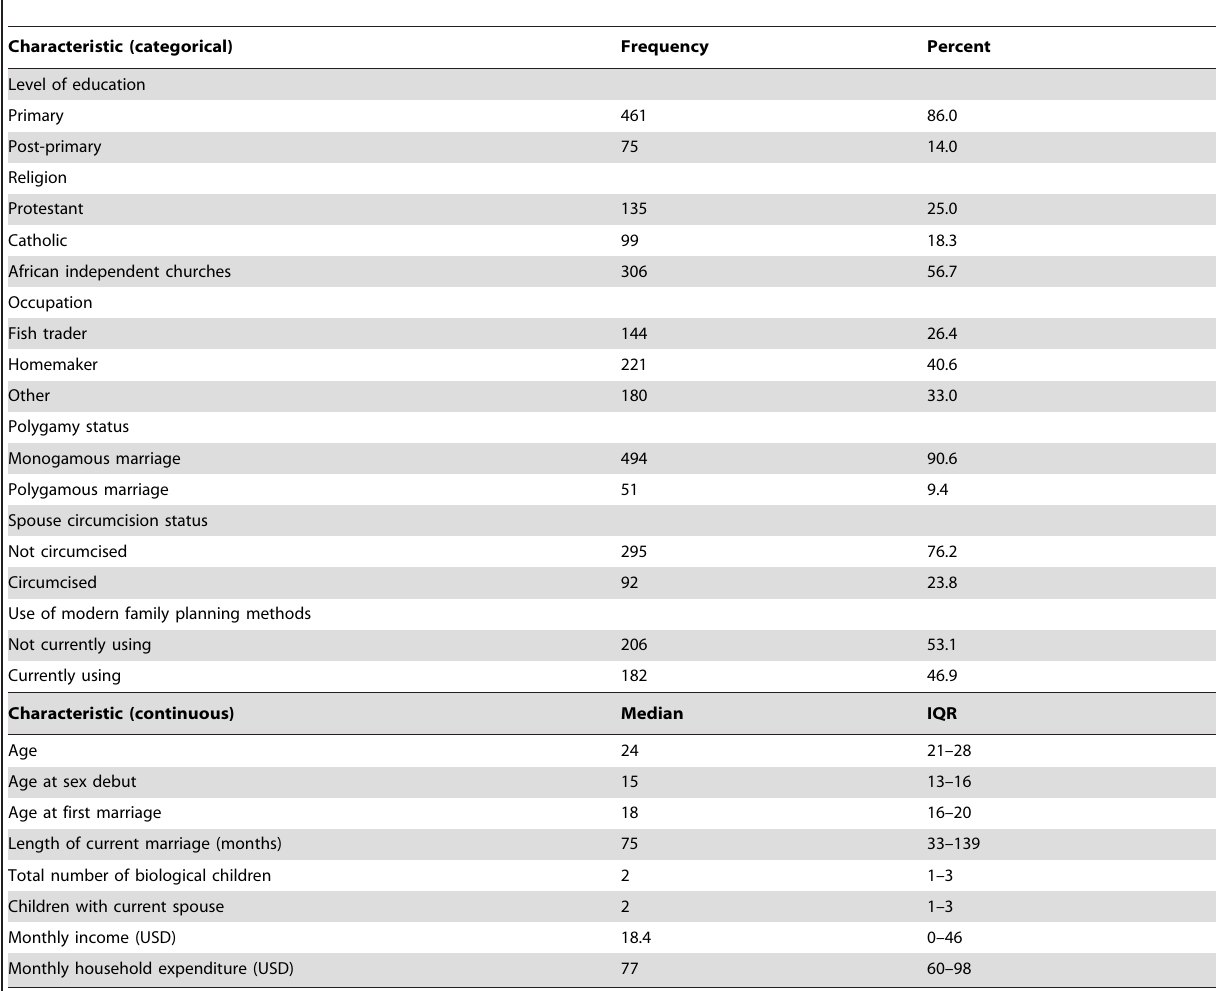
Table 1. Socio-economic and demographic characteristics of women married fishermen along Lake Victoria in Kisumu